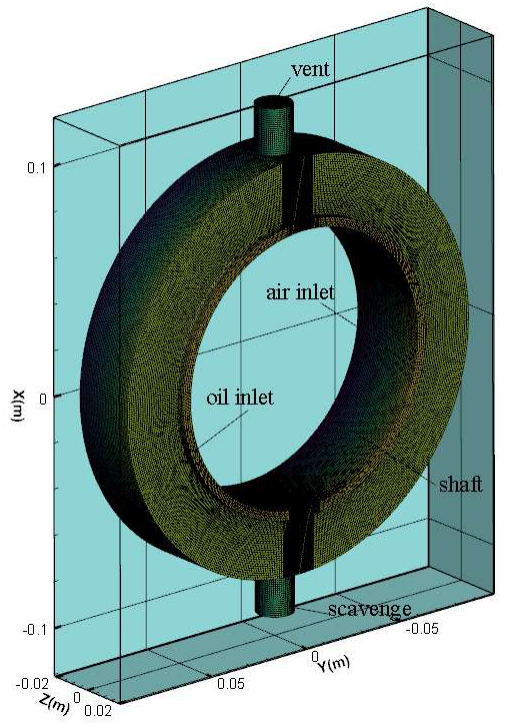
Figure 2. Grid model of the bearing chamber.